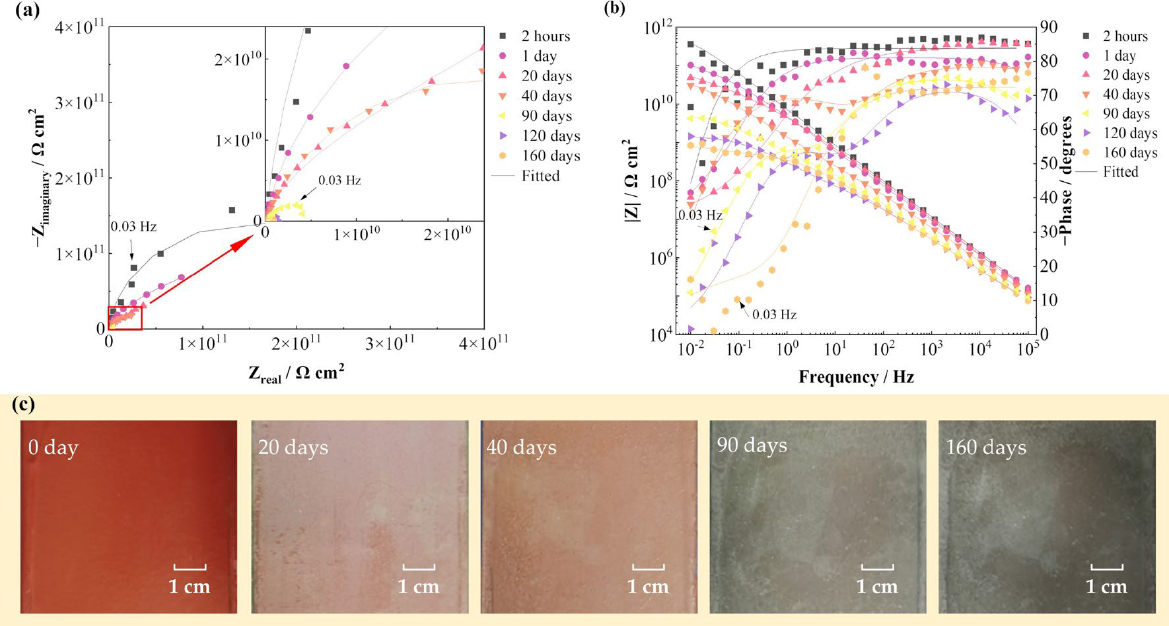
Figure 2. Surface micrographs of the FW-1 coating after immersion for different time. ( a ) 0 day, ( b ) 20 days, ( c ) 90 days and ( d ) 160 days.